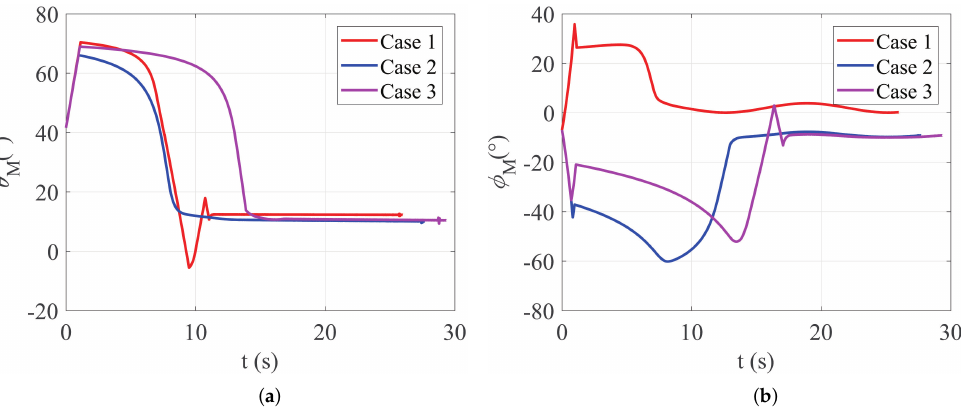
Figure 13. Variations of partial leading angles against variable maneuvering targets: ( a ) partial leading angles in pitch plane; ( b ) partial leading angles in yaw